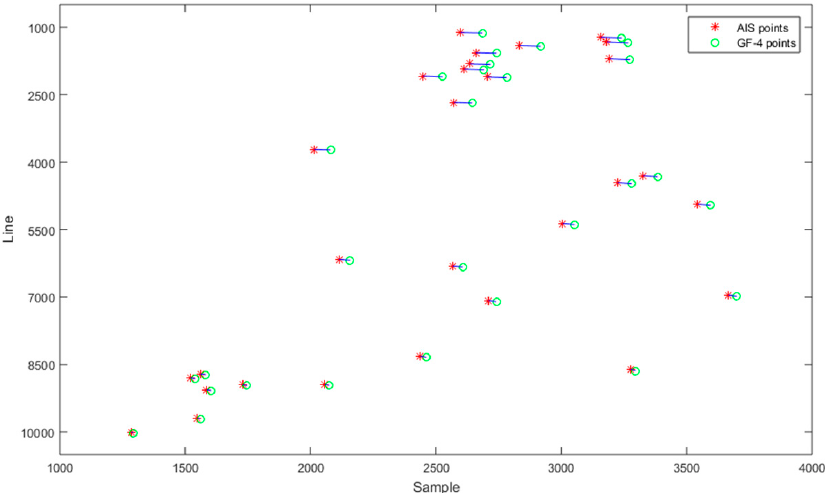
Figure 12. The point pairs in the first frame used for geometric correction. The blue lines connecting AIS points and GF-4 points denote the associations between point pairs.